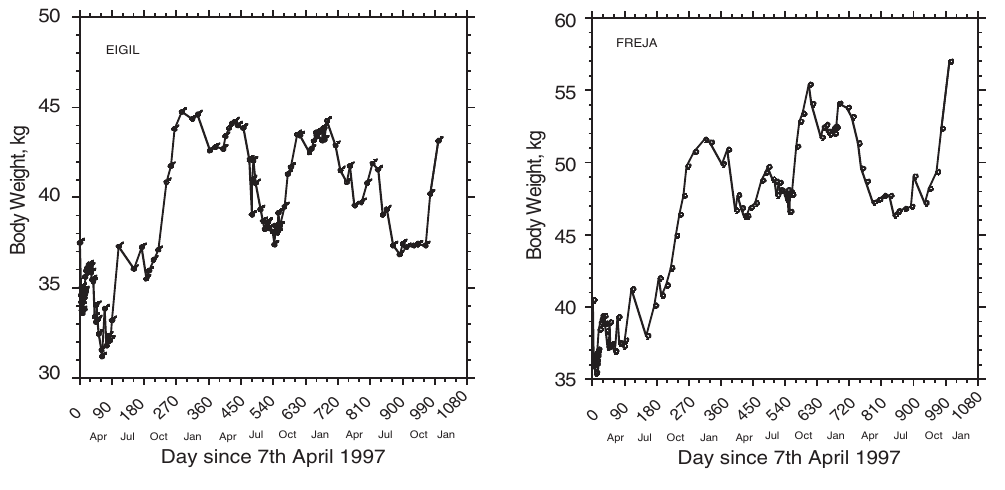
Fig. 5. Growth and seasonal varia- tions in body weight for Eigil and Freja.